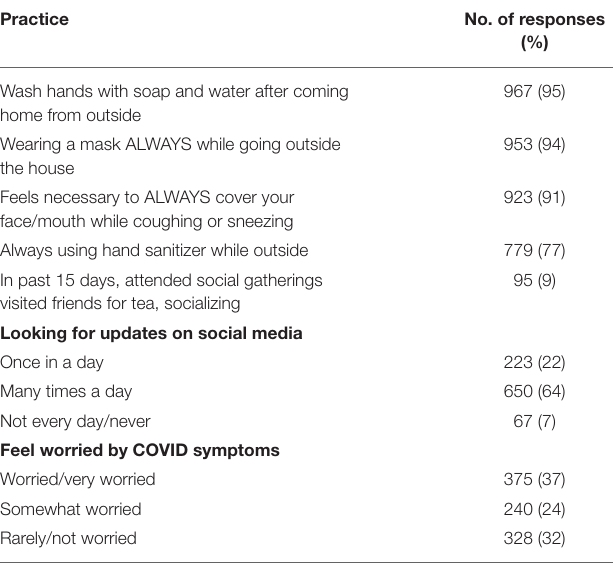
TABLE 5 | Reported practices and behavior related to COVID